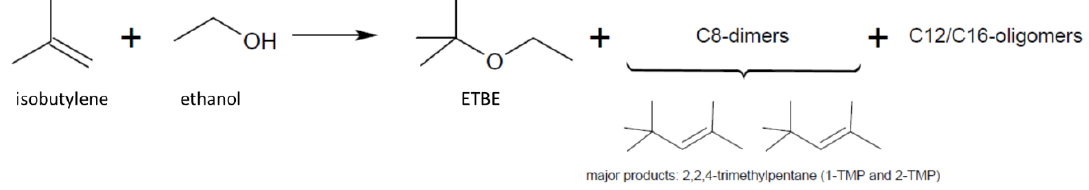
Figure 2. Reaction scheme for the conversion of isobutylene with ethanol. Possible reaction products: ethyl tert -butyl ether (ETBE), C 8 , and C 12 /C 16 derivatives.